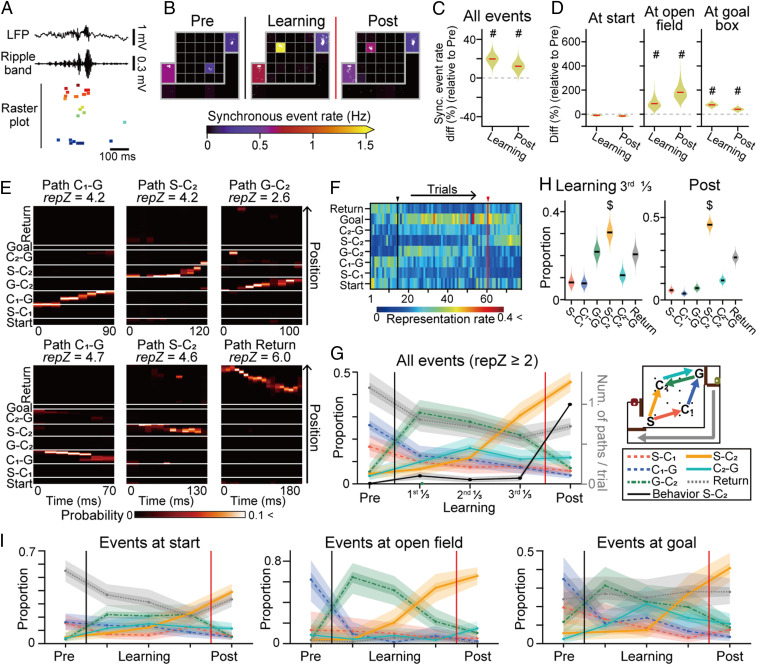
Prioritized representation of new episodes by learning-dependent synchronous events. (A) An SWR-associated synchronous event. (B) Pseudocolor maps of the average frequencies of synchronous events from all animals and trials, presented for a visualization purpose. The synchronous event locations are indicated by superimposed white dots. (C) Distributions of the percentage of changes in synchronous events during the learning and postlearning phases compared to the prelearning phase. A pound sign (#) indicates that 0 is not in the 95% credible interval computed from the posterior probability distribution by MCMC. (D) Same as C, but separately plotted for the individual areas. (E) Bayesian decoding of animal trajectories from single synchronous events (from Rat 1). Paths with the highest z-scored representation rates (repZ) are indicated above. The same datasets are magnified and the corresponding raster plots are presented in Fig. 4A. (F) Color-coded matrices of representation rates for each path by a single rat (the other four rats are shown in SI Appendix, Fig. S11B). The black and red vertical lines indicate the reward replacement and learning points, respectively. (G) Learning-related changes in the proportions of represented paths by synchronous events. The learning phase was evenly divided into three phases (first, second, and third learning phases). The thick and thin shaded areas indicate the 50% and 95% credible intervals, respectively. For comparison, the numbers of passes on path S-C2 per trial, presented in Fig. 1G, are superimposed by the black line. (H) The data in G were specifically analyzed for the last one-third of the learning and postlearning phases. A dollar sign ($) indicates an overlap of less than 5% with any other distribution. (I) Same as G, but for separately plotted individual areas.